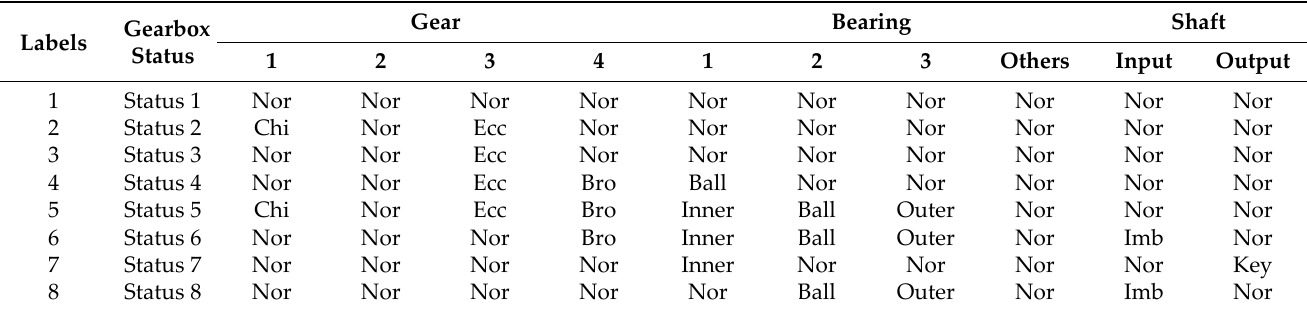
Table 1. Detailed information on different working statuses.